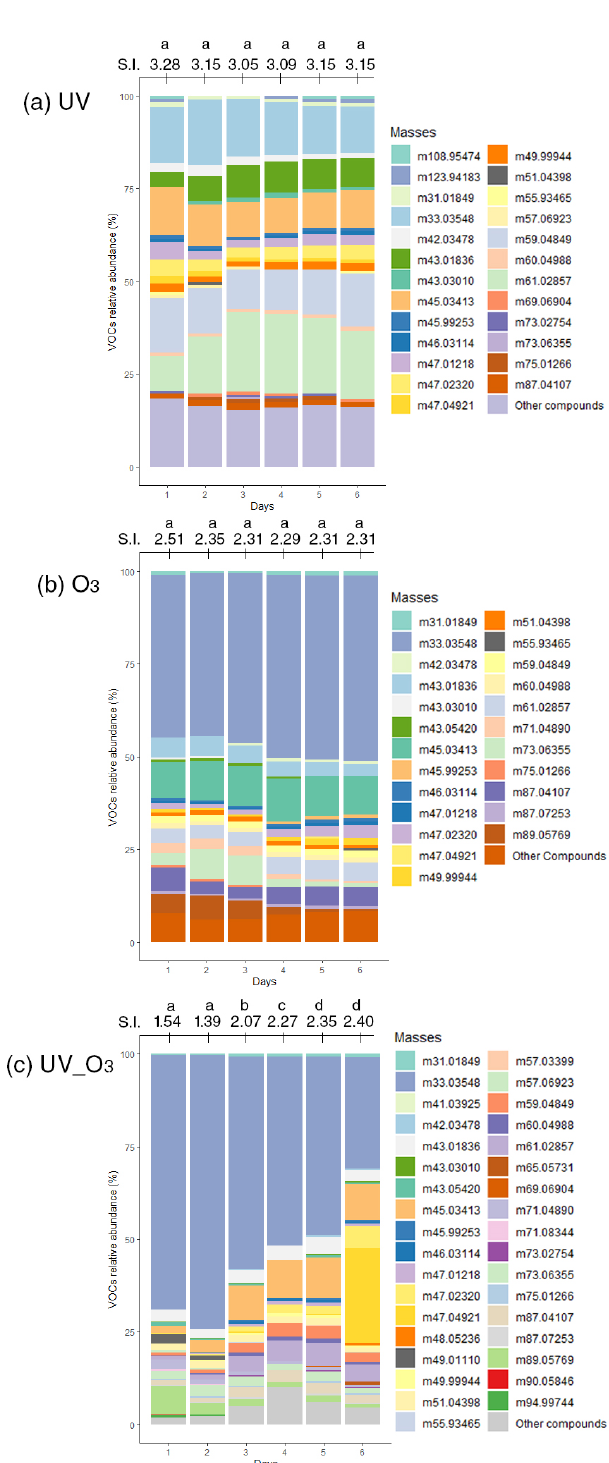
Figure 5. VOC relative abundance for rapeseed litter samples un- der (a) UV light (b) O 3 , and (c) UV_O 3 conditions. S.I. is the Shan- non index representing the diversity of the VOC (for each day). Letters indicate significant differences of the S.I. according to the Tukey test with p value <